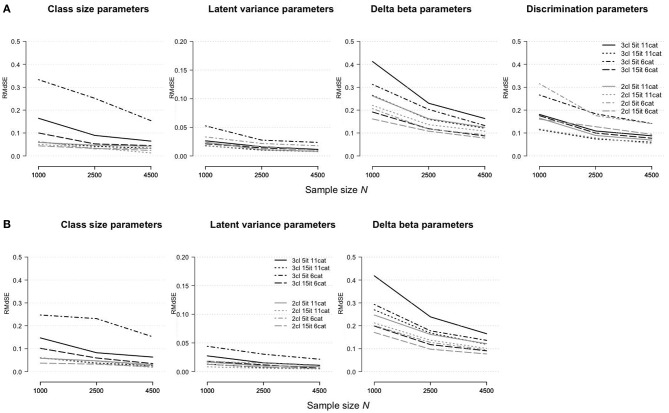
Root median squared error for parameter estimates in (A) the rmGPCM-3 and (B) the mPCM-3 under further data conditions.